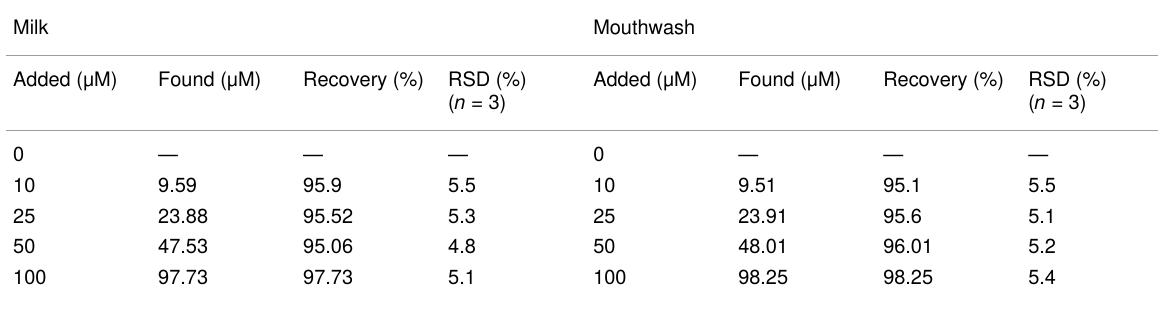
Table 2: Results of determination of hydrogen peroxide in real